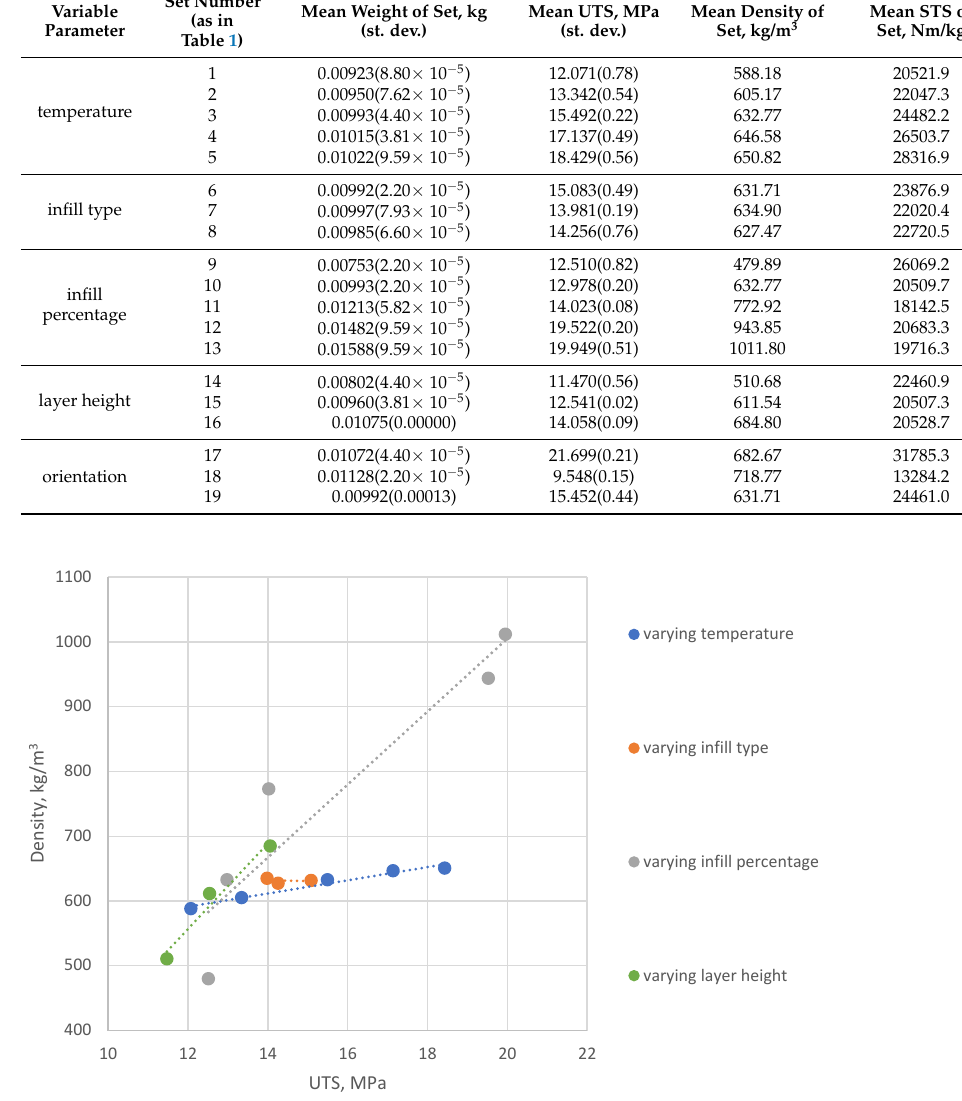
Figure 5. Graphical representation of UTS vs. specimens’ density measured data (PLA): varying temperature—sets No. 1–5; varying infill type—sets No. 6–8; varying infill percentage—sets No. 9–13; varying layer height — sets No. 14 – 16.